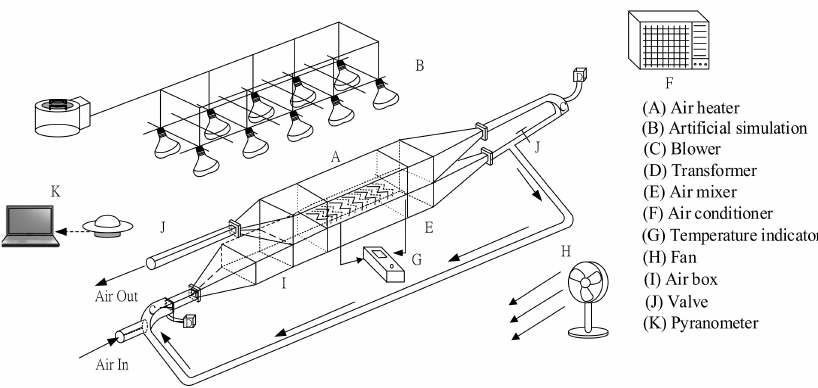
Figure 4. Schematic of a recycling double-pass W-ribs solar air